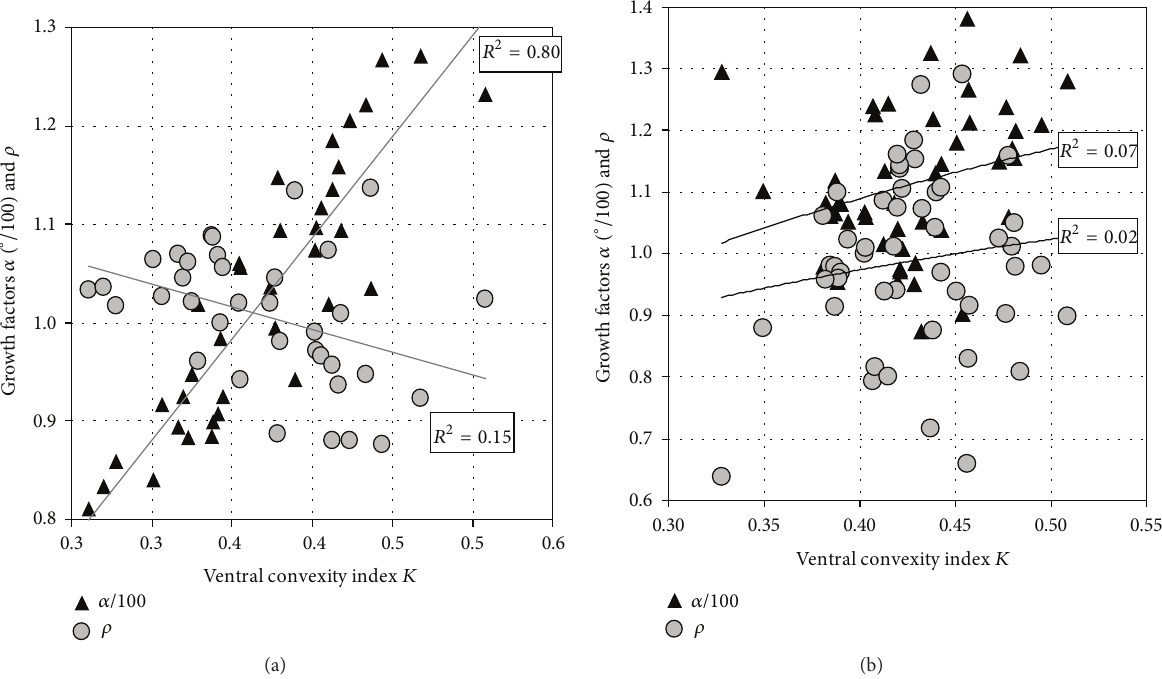
Figure 5: The ventral convexity K plotted against the growth-based parameters 𝛼 and 𝜌 , for 36 species within the genus Donax (a) and 49 species within the genus Tellina (b)— black triangles : apical angle 𝛼 ( ∘ /100); grey dots : differential growth index 𝜌 . The increase of 𝛼 and decrease of 𝜌 with growing K for Donax are highly significant ( 𝑃 < 0.0001 ) and significant ( 𝑃 = 0.02 ), respectively. For Tellina , the trends are not significant ( 𝑃 > 0.05 for